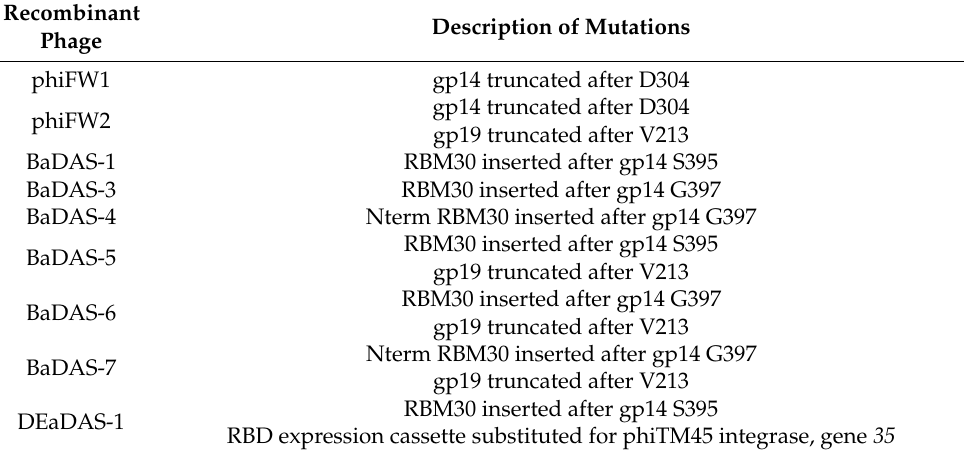
Table 1. Recombinant phages constructed in this